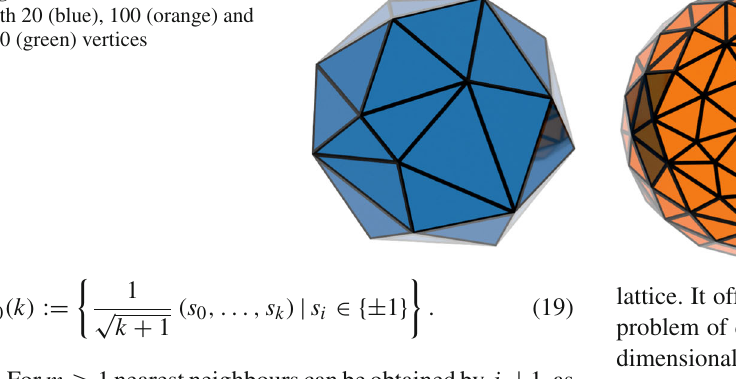
Fig. 1 Fibonacci lattices on S 2 with 20 (blue), 100 (orange) and 500 (green)